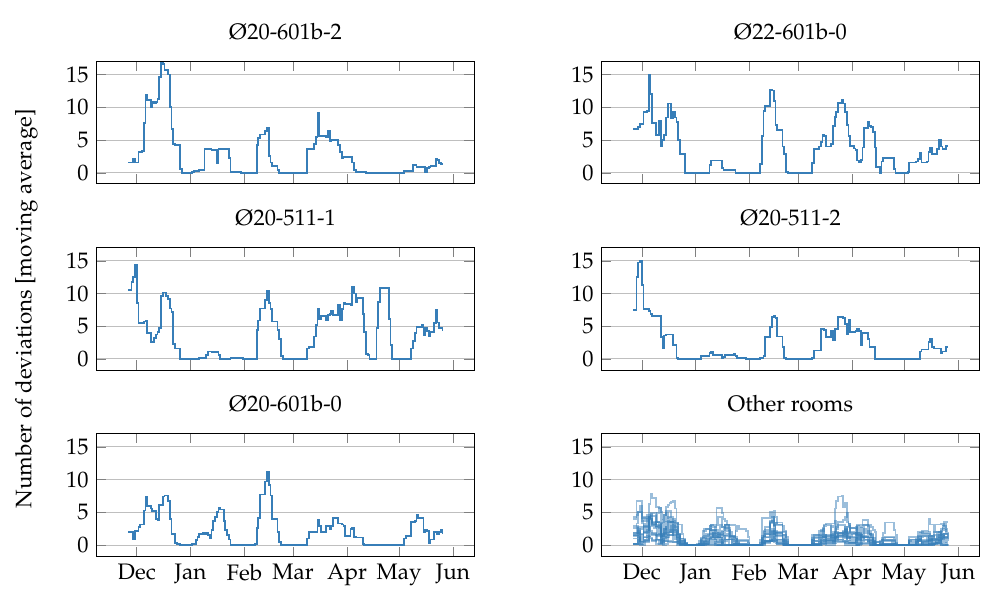
Figure 10. Moving average of deviations for classrooms. In the first five plots, the rooms which frequently deviate from the common behaviour are shown separately. The rest of the rooms are shown together in the last